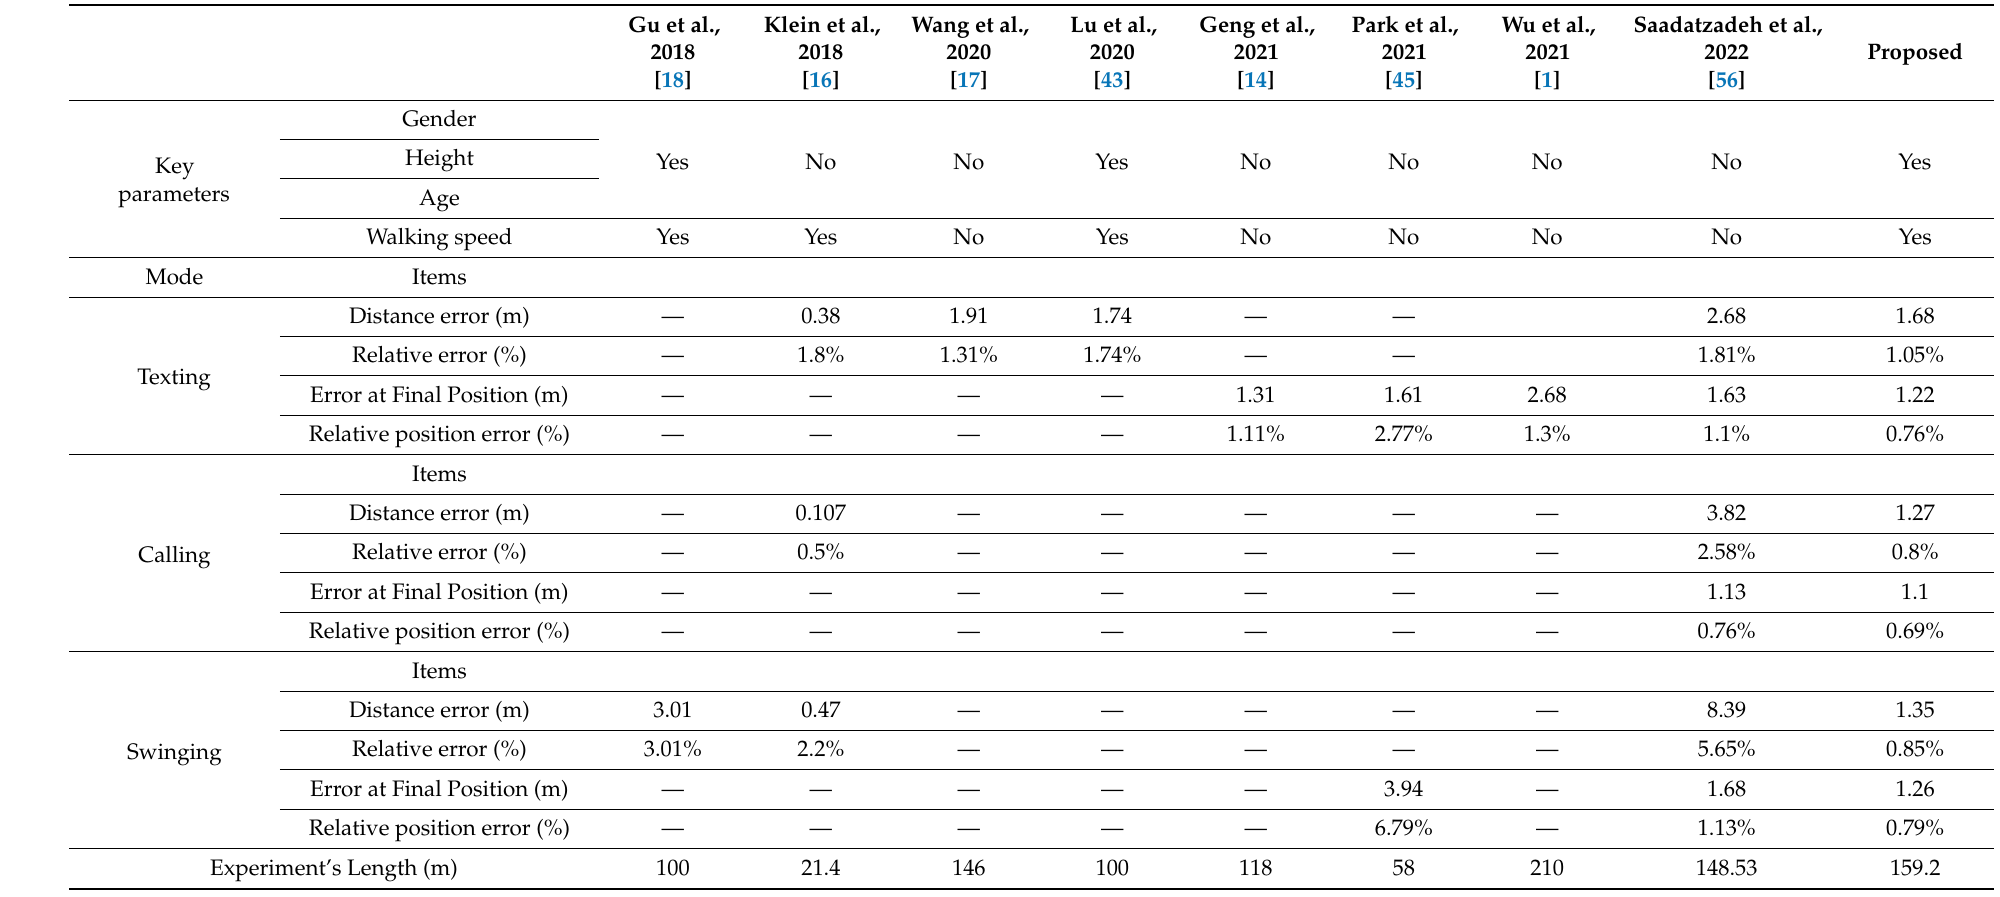
Table 13. Comparison of positioning and distance errors of recent PDR